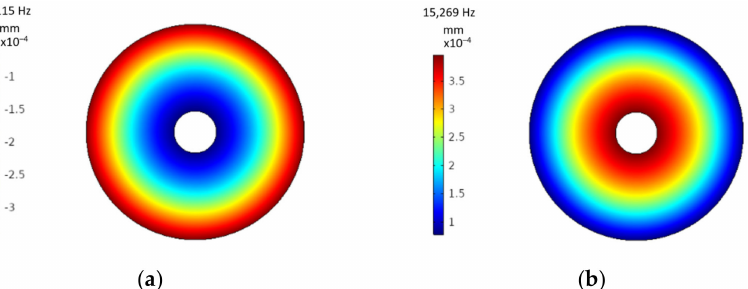
Figure 5. Tool holder with slots surface displacement heat map in longitudinal direction of the transducer at ( a ) torsional, ( b ) axial excitation vibrational modes.